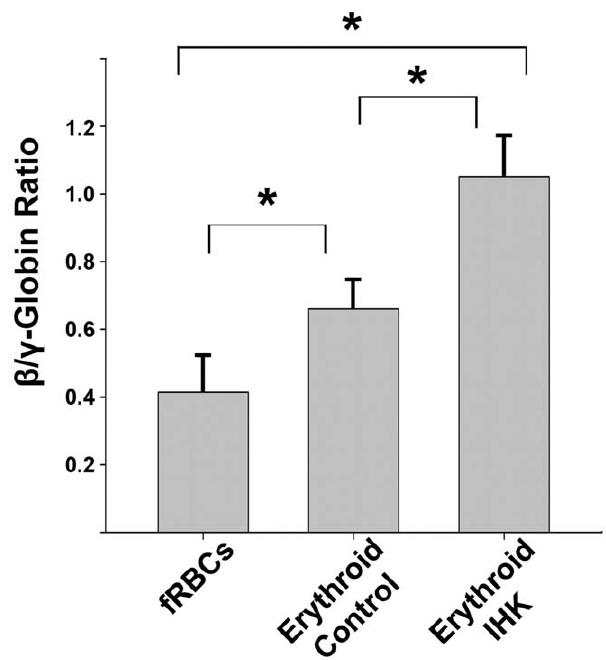
Figure 5. IHK-transduced CD34 + progenitors increase b -globin expression in erythroid progeny. Hypotonic lysates from fetal RBCs from the donor cords, erythrocytes from non-transduced CD34 + cells, and erythrocytes from IHK-transduced CD34 + cells were analyzed by RP- HPLC to determine relative quantities of individual globin chains. Data from three trials are presented as mean 6 SEM, * indicates p , 0.05, paired t-test.